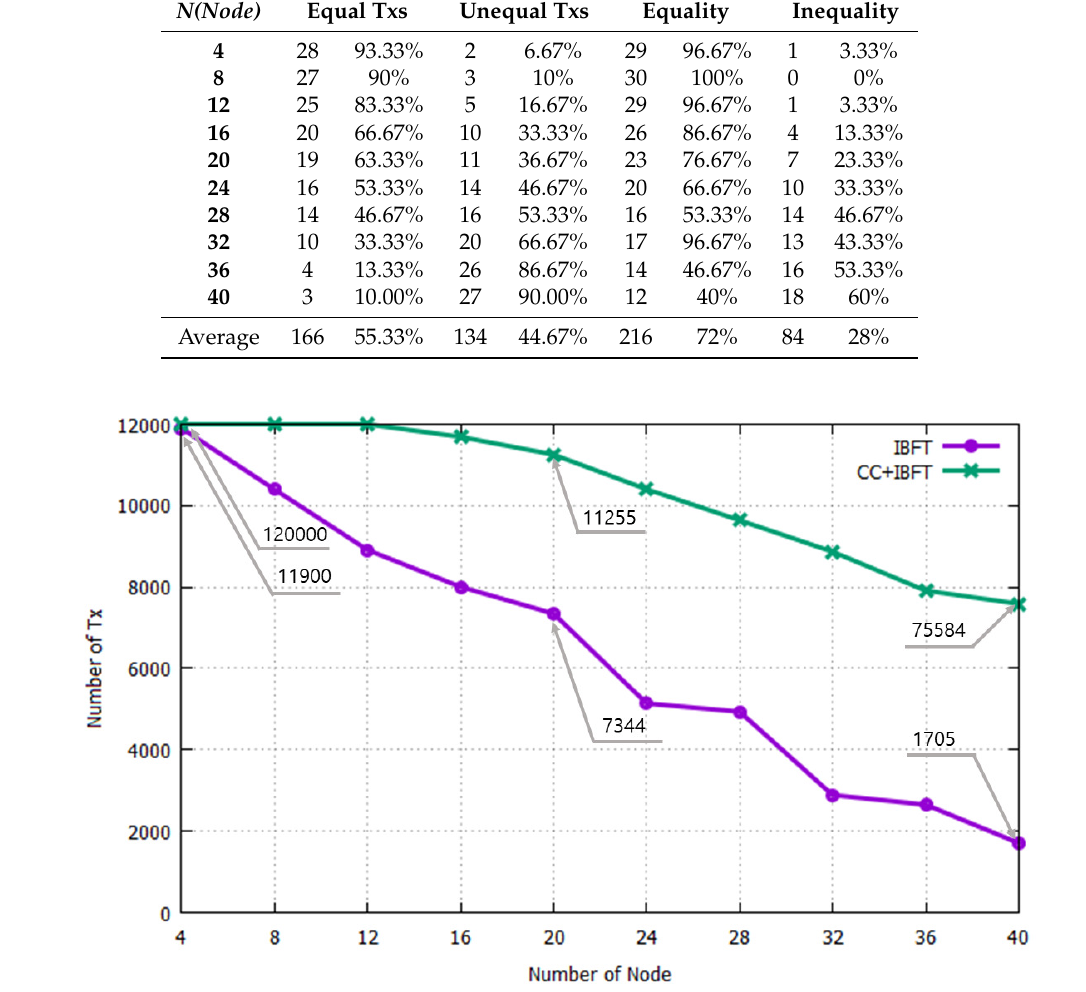
Figure 6. Comparing the amount of transactions between IBFT and CC + IBFT when the transaction generation interval is 25